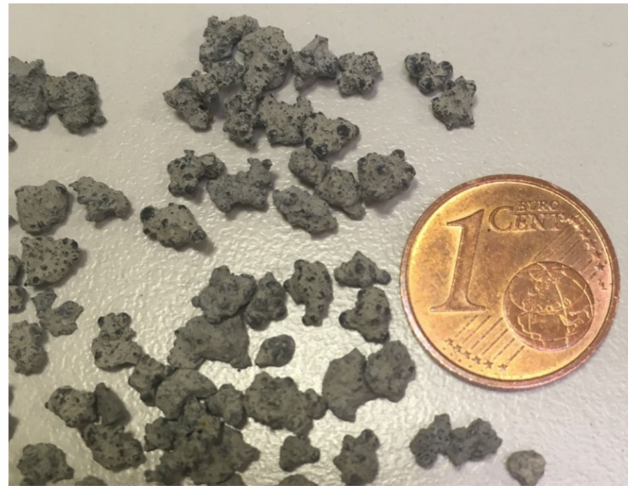
Figure 5. Conglomerate of spheres derived from black slag: ( a ) sample “BIG”, with ∅ ∈ [1.4; 2.0) mm; ( b ) sample “MEDIUM” with ∅ ∈ [0.71; 1.4) mm; and ( c ) sample “SMALL” with ∅ ∈ (0; 0.71) mm.